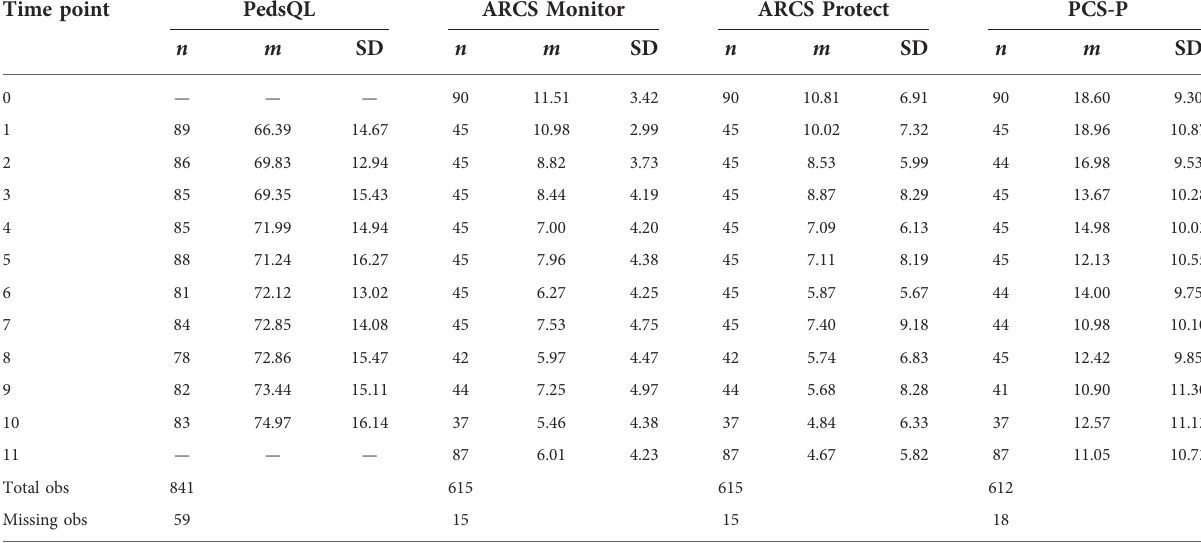
TABLE 3 Number of observations, observed means, standard deviations, and missing observations for weekly measures of outcome measure and proposed